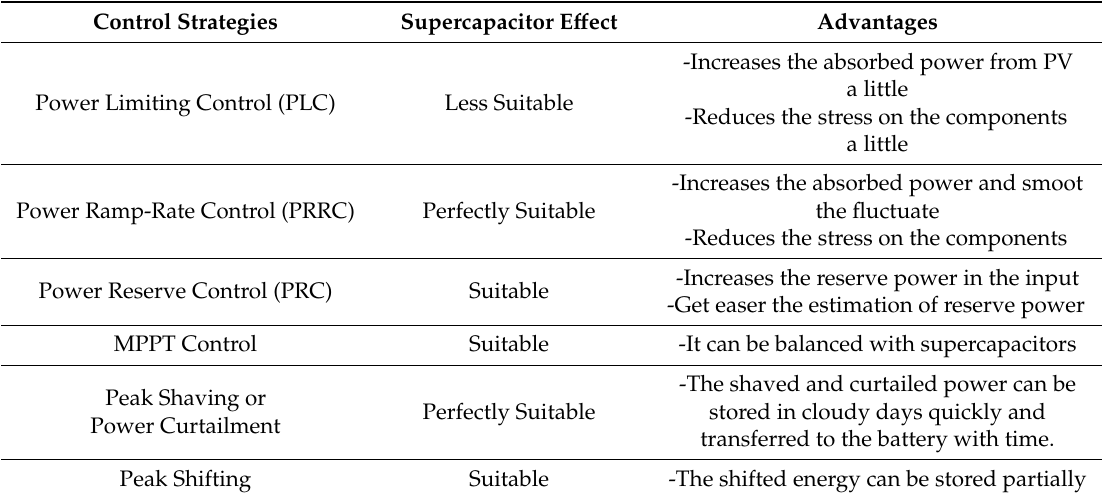
Table 4. The power control strategies with supercapacitors and their